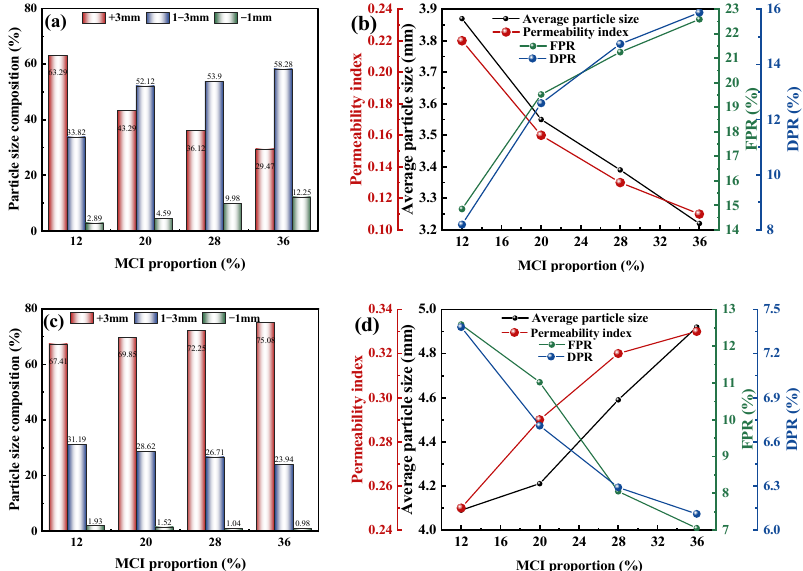
Figure 3. Effect of MCI proportion on granulation. Conventional granulation: ( a , b ); Pre-pelletizing granulation: ( c , d ).